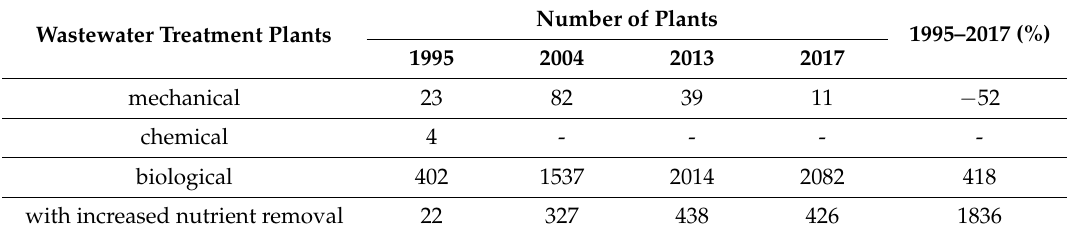
Table 2. Number of sewage treatment plants by